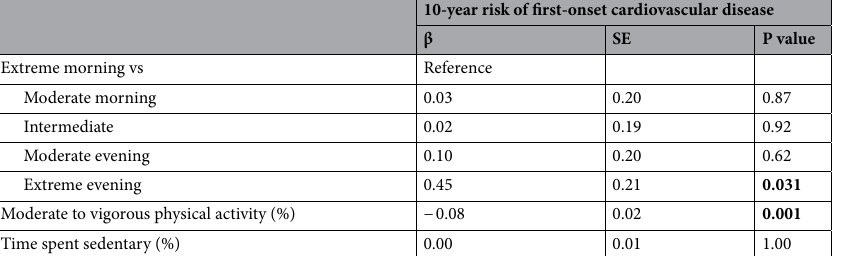
Table 3. Associations of chronotypes and physical activity pattern on 10-year risk of first-onset cardiovascular disease. Controlled for gender, age, body mass index, waist circumference, SES, smoking, unhealthy drinking, university education, work status and depression symptoms.